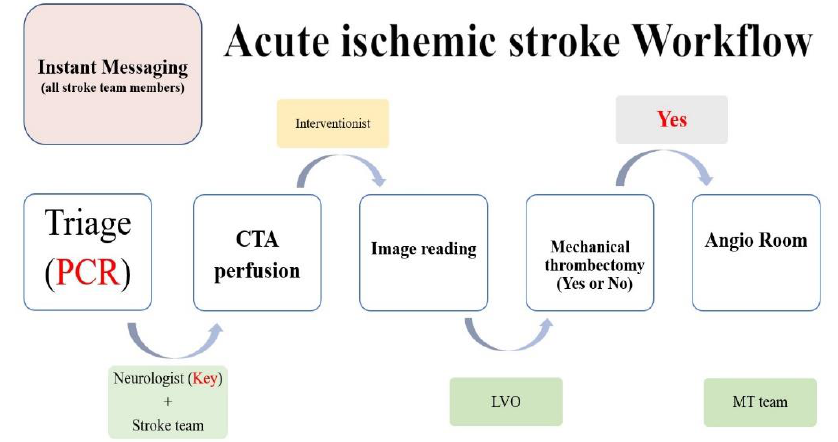
Figure 1. Prior to the COVID-19 pandemic, we developed protocols and corrected the shortcomings of treating AIS patients during monthly stroke-related meetings. (CTA: Computed Tomography Angiography. LVO: Large Vessel Occlusion. MT: Mechanical Thrombectomy.)